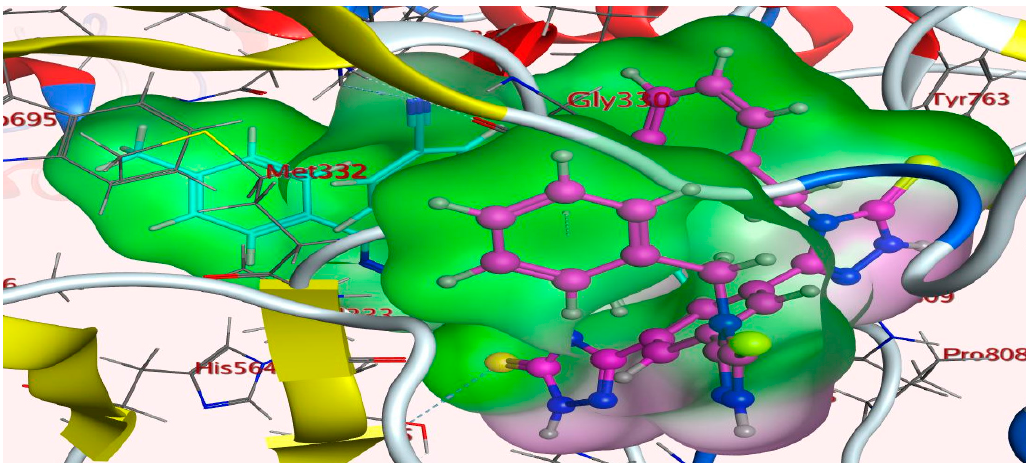
Figure 8. Surface map for the most active derivative 22 inside an active site.